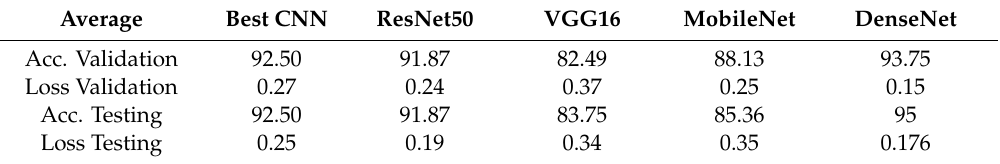
Table 11. Accuracy and loss of the proposed CNN model and benchmark CNNs.